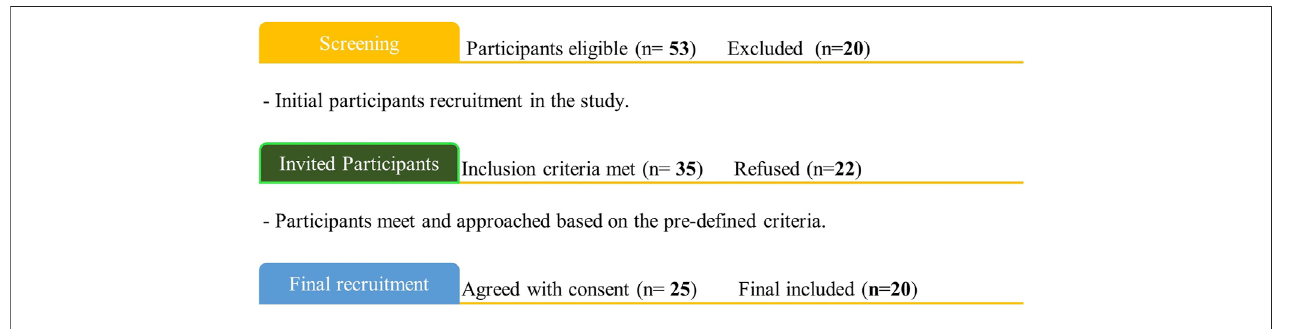
FIGURE 3 | process of the participants ’ recruitment.